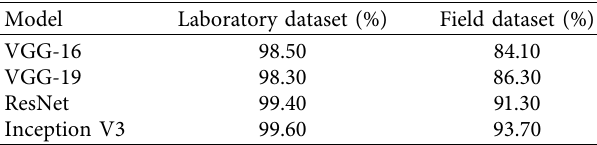
Table 4: Classification accuracy using